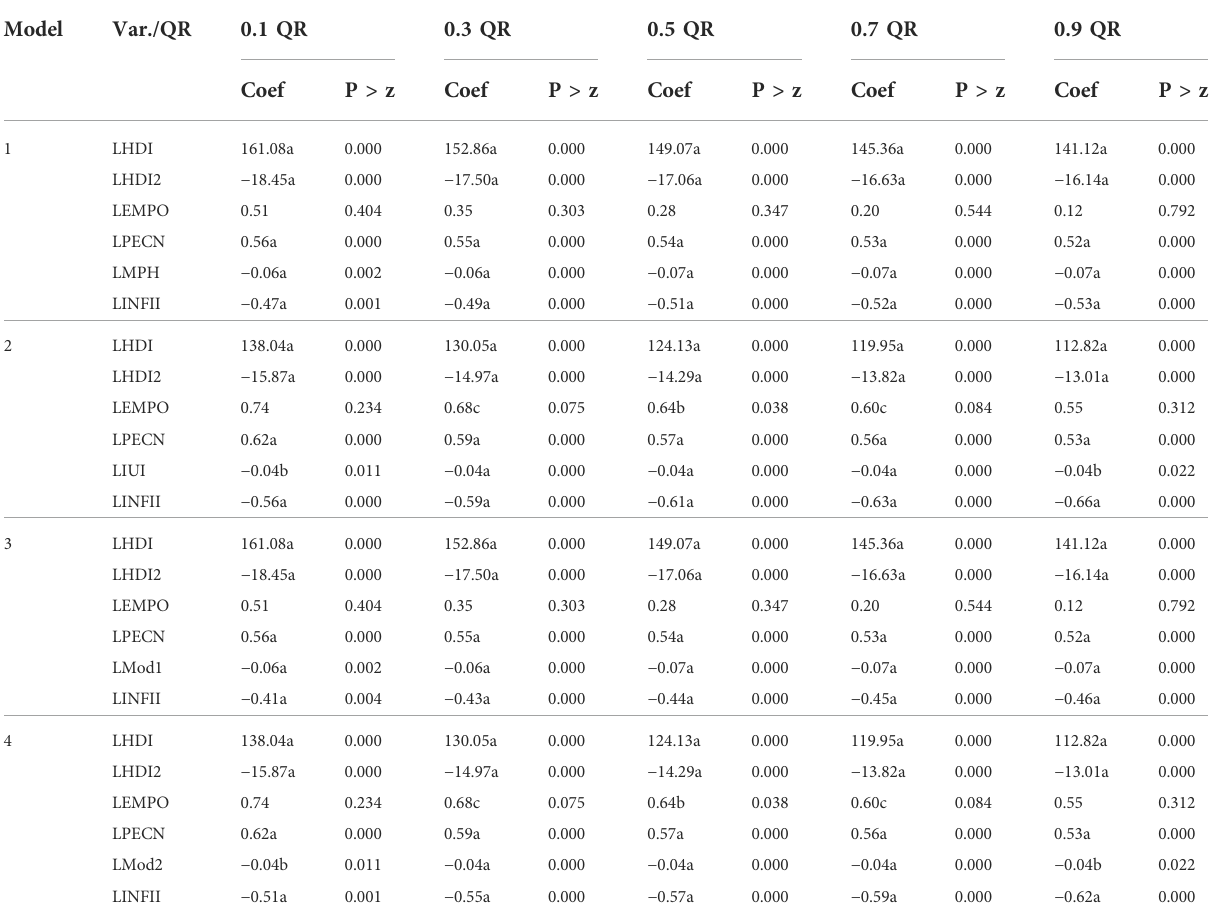
TABLE 5 Estimation results from the panel quantile regression model.